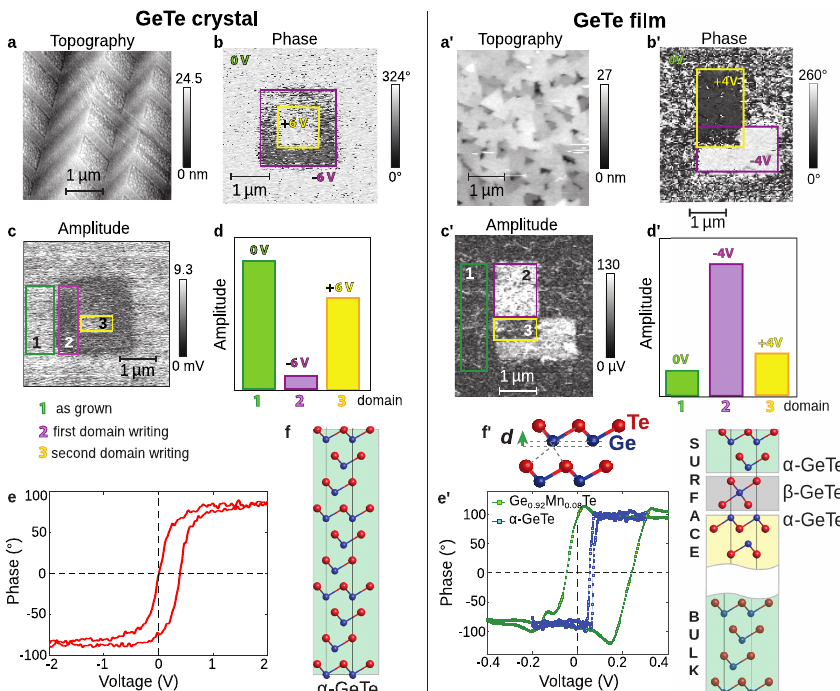
Figure 4. ( a ) atomic force microscopy; ( b ) PFM vertical phase; ( c ) PFM vertical amplitude signals